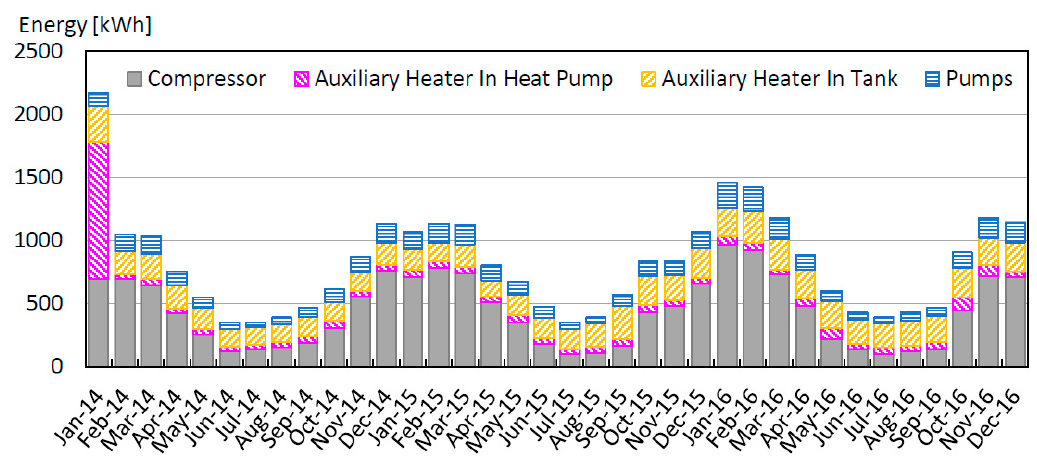
Figure 15. Measured monthly electrical energy consumption of GSHP system components.